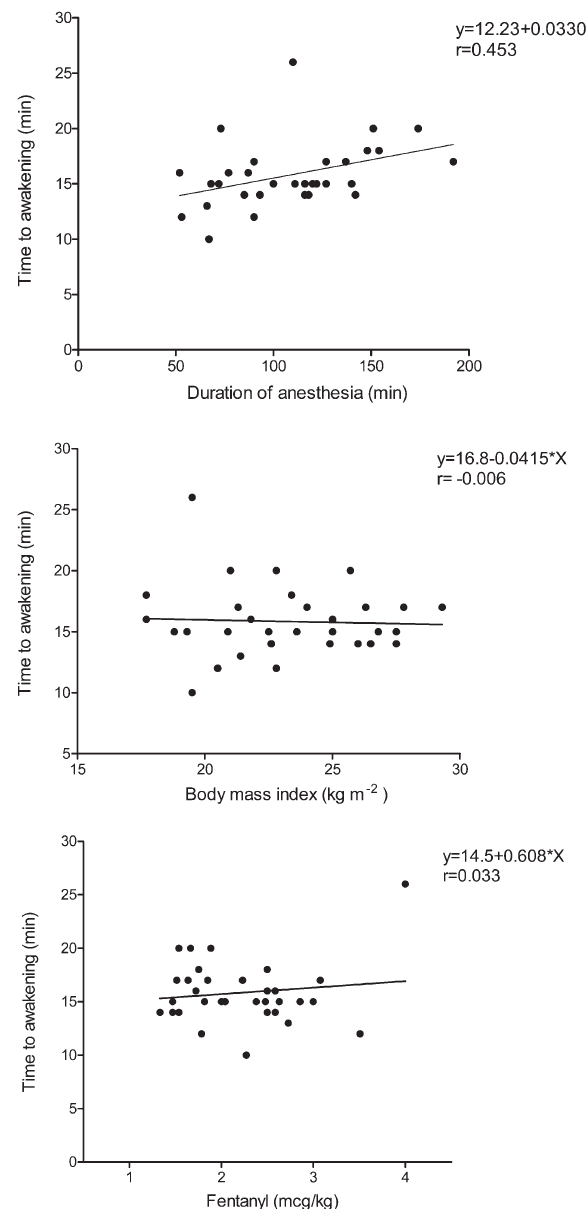
Figure 3 - The time to awakening after discontinuing 3.5% sevoflurane in gynecologic surgical patients was prolonged by the duration of anesthesia ( P =0.006) but was not correlated with the body mass index ( P =0.971) or total fentanyl dose (